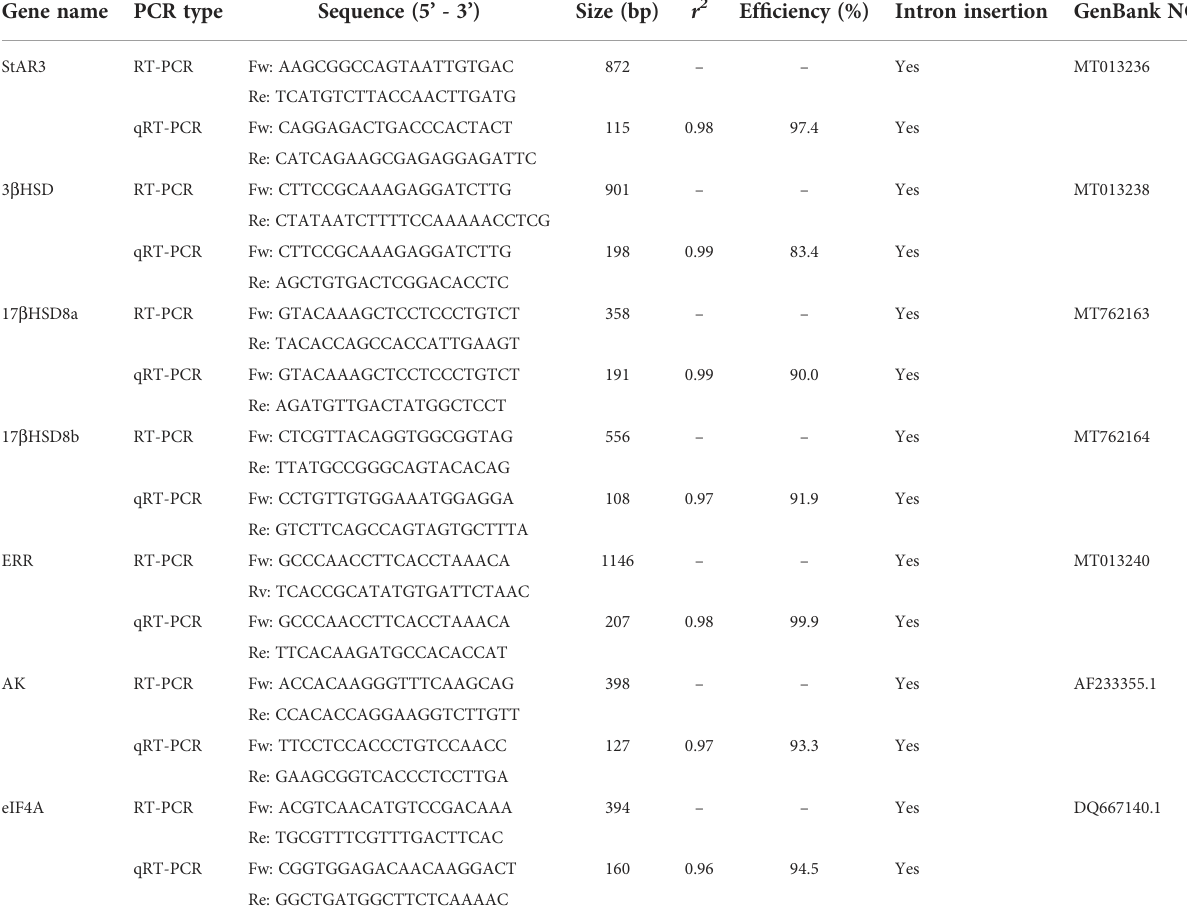
TABLE 2 Gene speci fi c primers used for RT-PCR and RT-qPCR